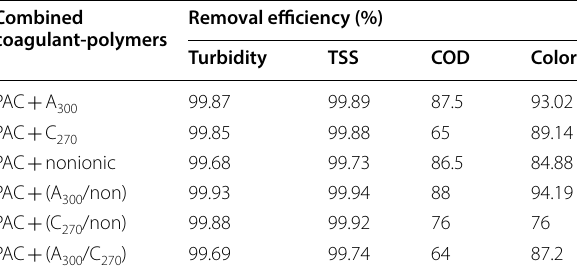
Table 3 Comparison of Turbidity, TSS, COD and color removal efficiency for different combined coagulant- polymers options Combined Removal efficiency coagulant-polymers